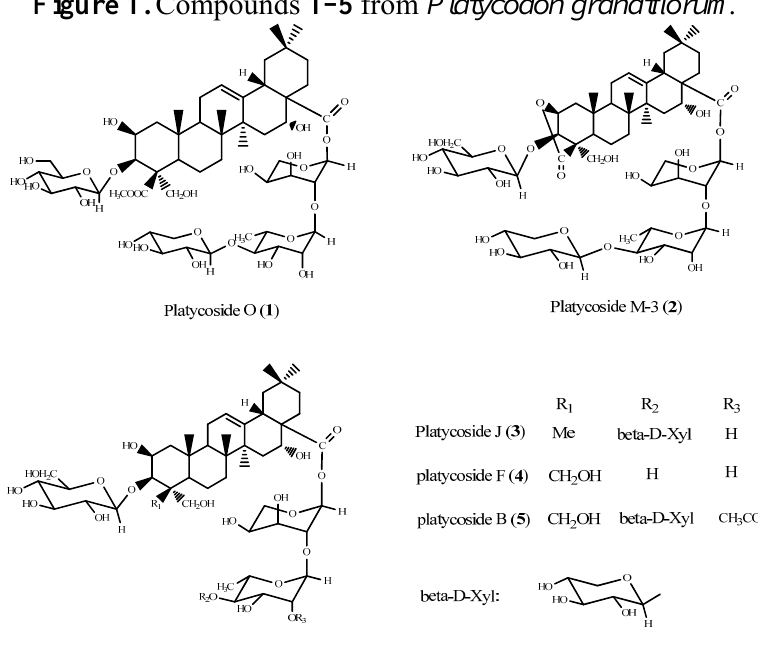
Figure 1. Compounds 1–5 from Platycodon grandiflorum